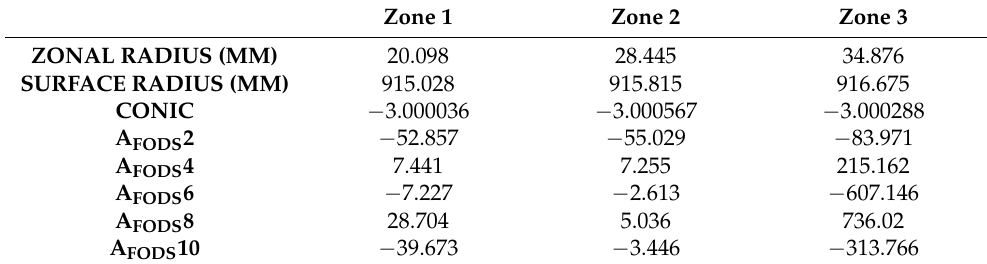
Table 2. Parameters of the HMID.